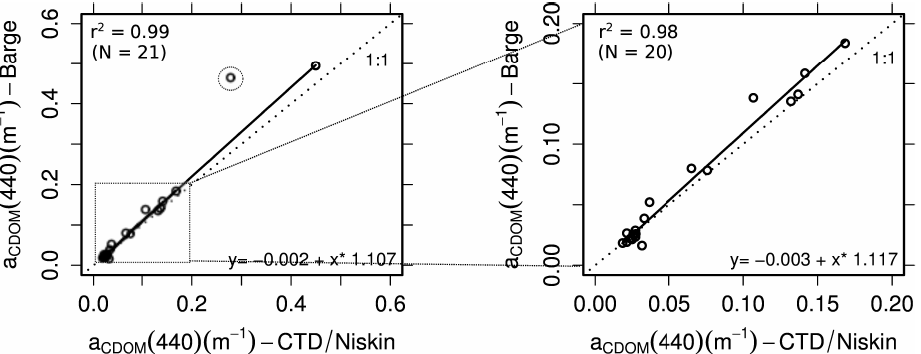
Fig. A1. Comparison of a CDOM (440) values between samples from a CTD/Niskin and from a barge. (a) a CDOM (440)-Barge vs. a CDOM (440)-CTD/Niskin at a CDOM (440) < 0.5m − 1 (all data points included, N = 22) and (b) a CDOM (440)-Barge vs. a CDOM (440)- CTD/Niskin at a CDOM (440) < 0.20m − 1 (N = 20). In both cases, the slope of a CDOM (440)-Barge vs. a CDOM (440) -Niskin relationship was found to be significantly different from 1 ( p < 0 . 0001 for both figures a and b).